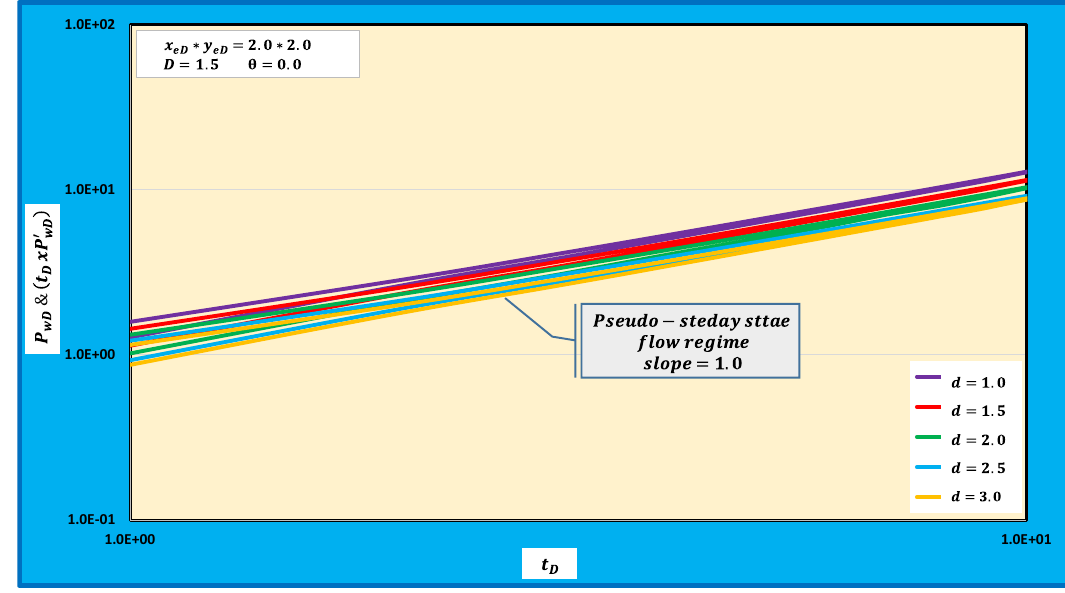
Fig. 26 Pressure and pressure derivative behaviors during pseudo-steady state flow regime for different fractal dimensions